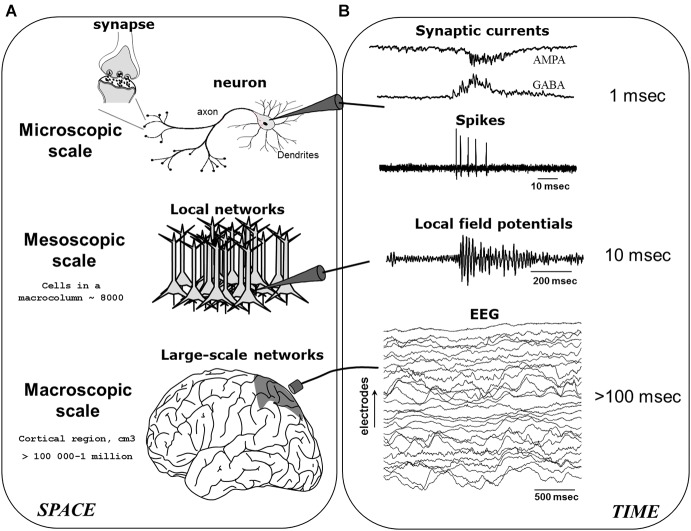
The generation of electroencephalogram (EEG) network oscillations. EEG signals are generated by the integration of neural activity at multiple spatial (A) and temporal (B) scales. After Le Van Quyen (2011).